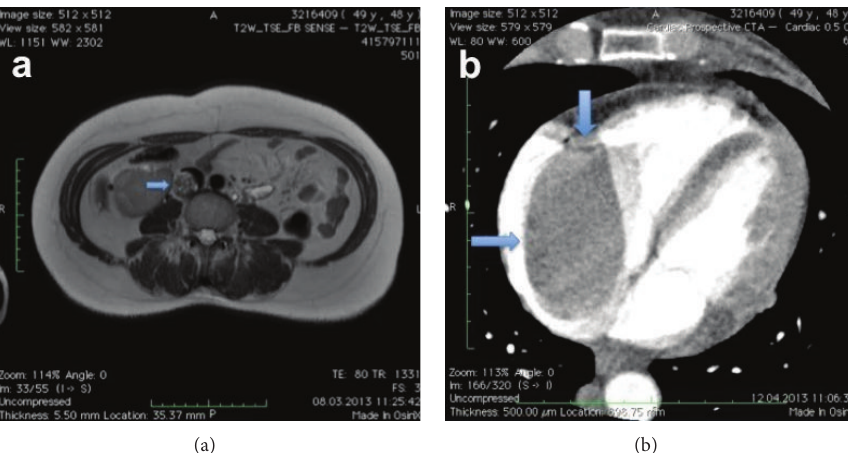
Figure 1: (a) Magnetic resonance venography of the patient at preoperative period (intravenous mass from right internal iliac vein to inferior vena cava, arrowed), (b) view of right atrial mass with venous filling defect (arrowed).